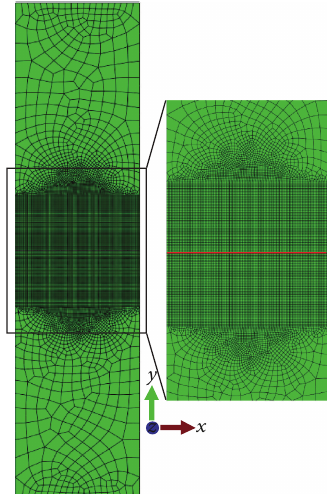
Figure 5: A finite element mesh used in the crack propagation analysis.